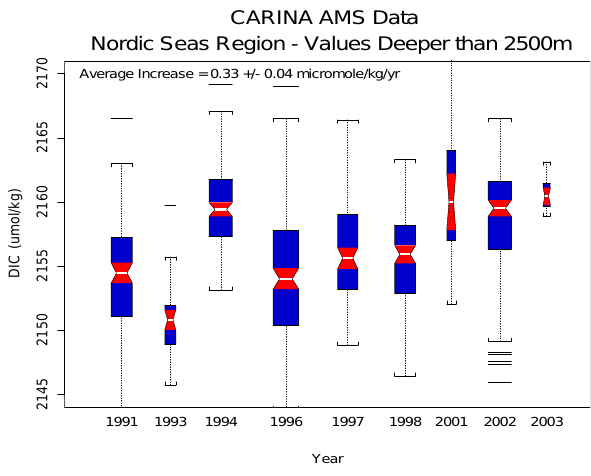
Figure 5. This boxplot shows deep water DIC measurements from the same region as Fig. 4. A significant fraction of the spread in- dicated by each box is due to spatial variability. In spite of the crude nature of this summary, the average concentration increase over time is statistically significant at a very high confidence level. The increase rate derived here is only about half that found for the Irminger Basin alone. For this discussion the important point is that the secondary QC adjustments have not erased subtle large scale temporal